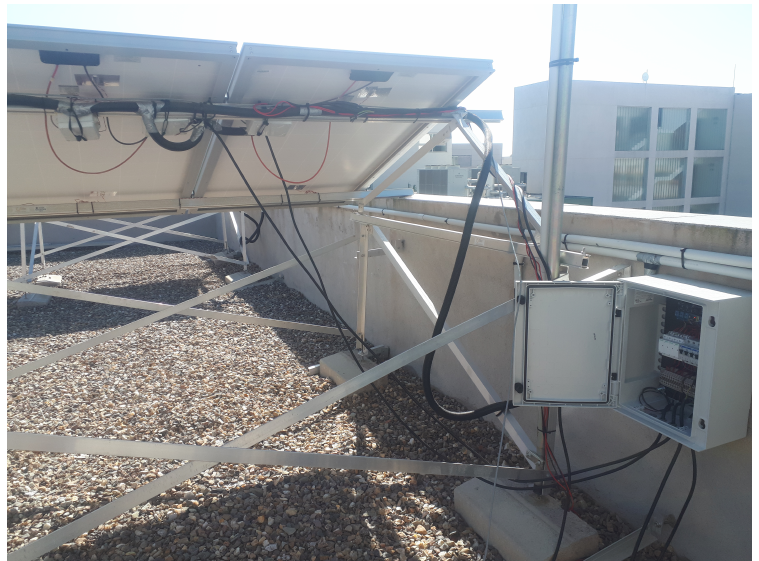
Figure 6. UHU-MUX multiplexer installed at the experimental PV facility of the Universidad de